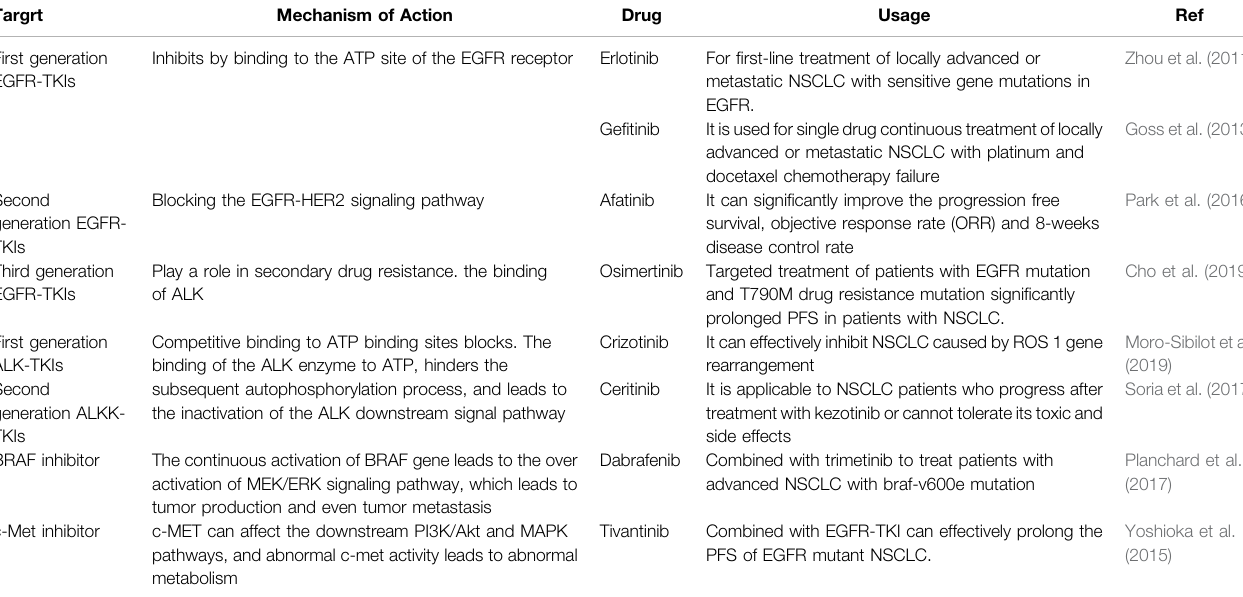
TABLE 1 | Summary of targeted therapeutic drugs for non-small cell lung cancer.